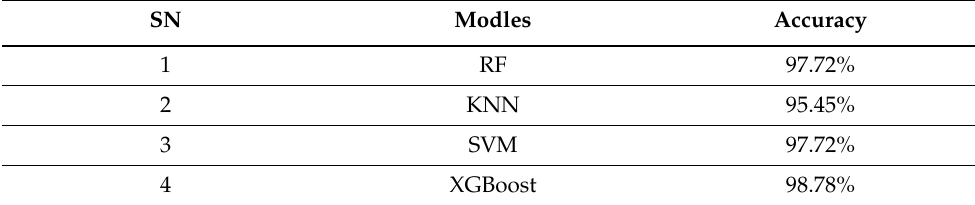
Table 2. Summary of the four model prediction